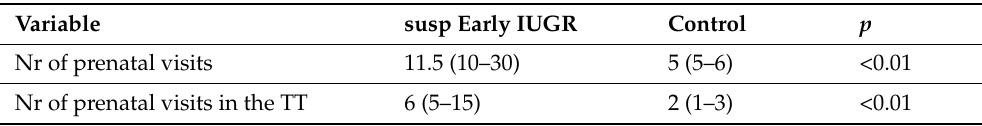
Table 2. Number of prenatal visits in pregnancy and in the third trimester in the study IUGR group versus the control group.